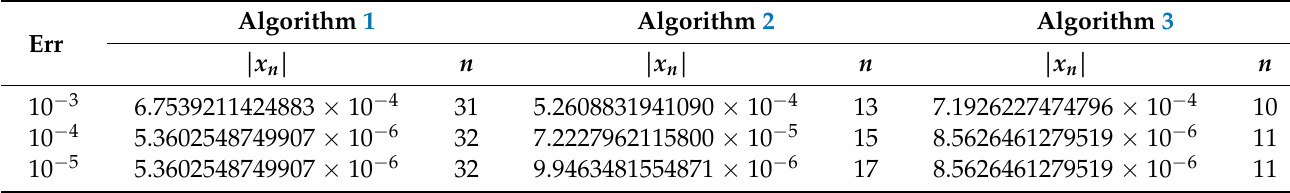
Table 3. Numerical results for Example 4 in Case III.